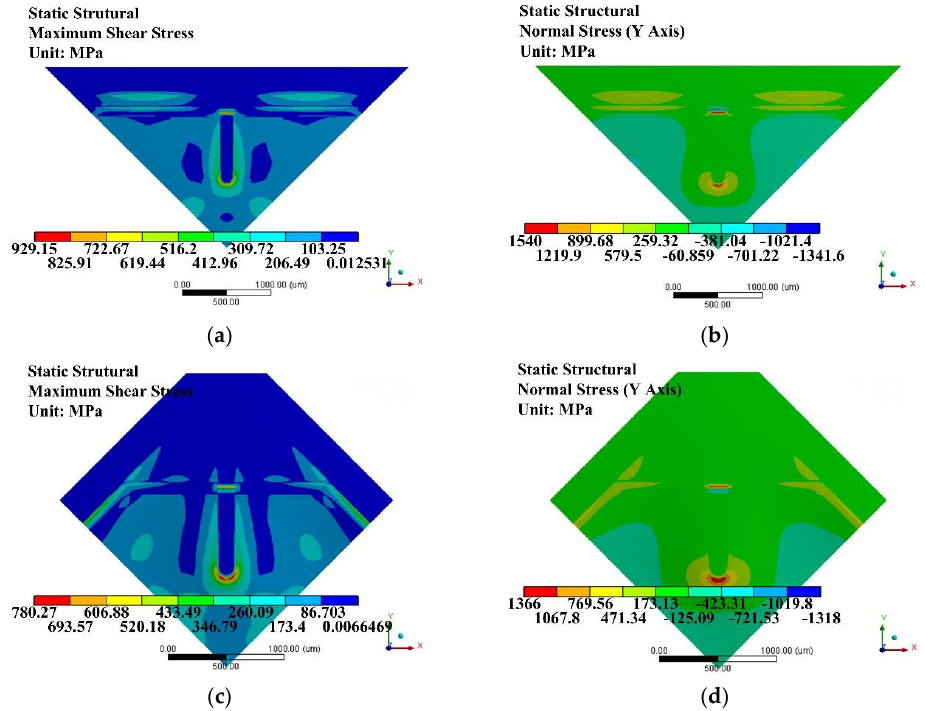
Figure 22. Stress distributions under overload condition based on anti-overload glass base with stepped structure under 1 atm: ( a ) shear stress γ distribution of improved diaphragm I; ( b ) tension stress S y of improved diaphragm I; ( c ) shear stress γ of improved diaphragm II; ( d ) Tension stress S y of improved diaphragm II.